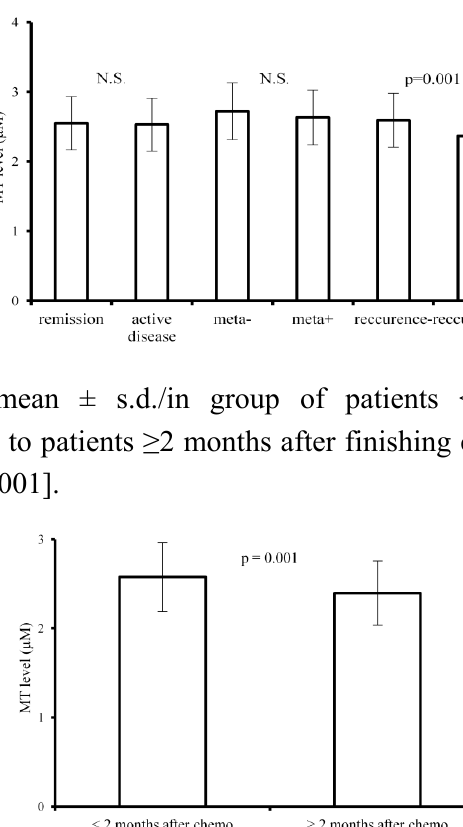
Figure 2. Relation of MT level/mean ± s.d./to clinical parameters. N.S.: not significant. p = 0.001: statistically significant on the level of 0.1%. There were no statistically significant differences between MT levels in patients with active disease and in remission or in patients with generalized disease and with cancers without metastasis.